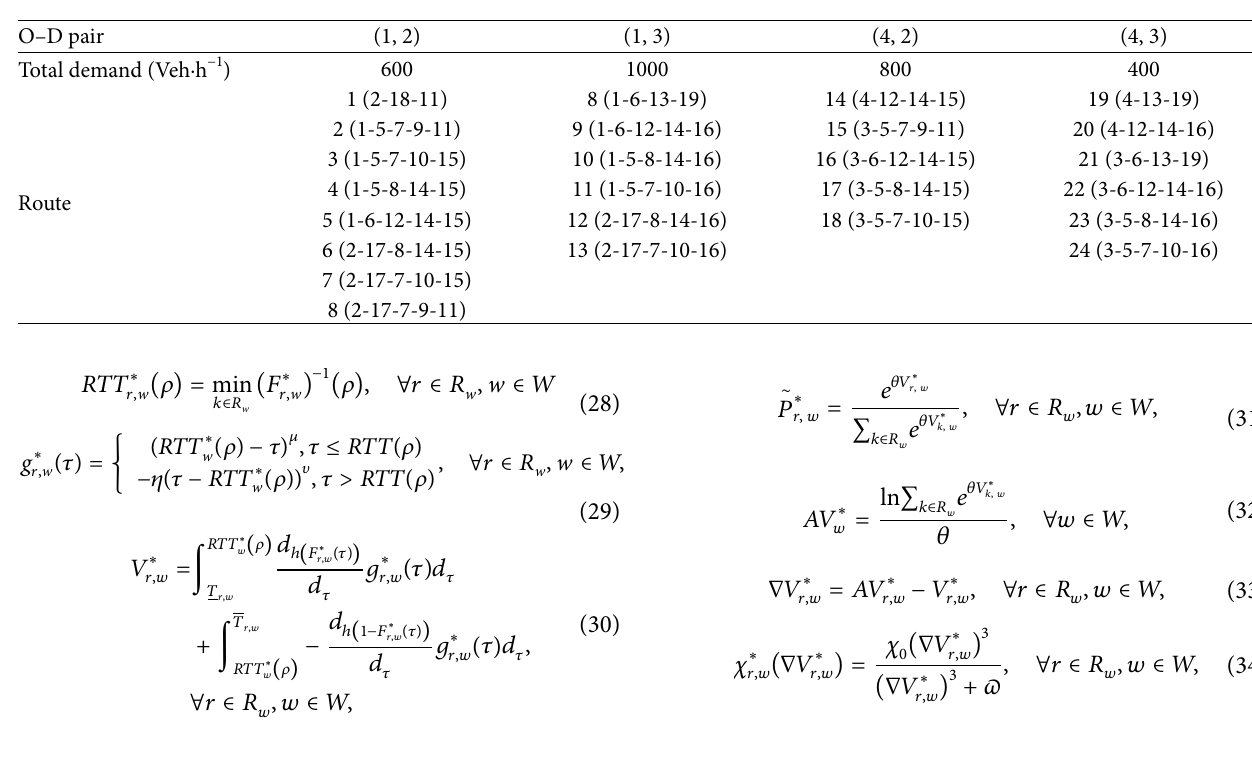
Table 2: OD demands and